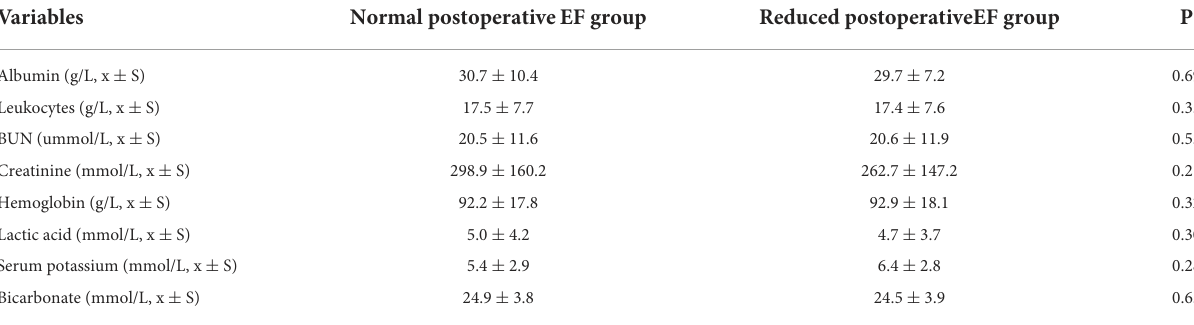
TABLE 3 Comparison of laboratory indicators upon initiation of CRRT between the normal postoperative EF group and the reduced postoperative EF